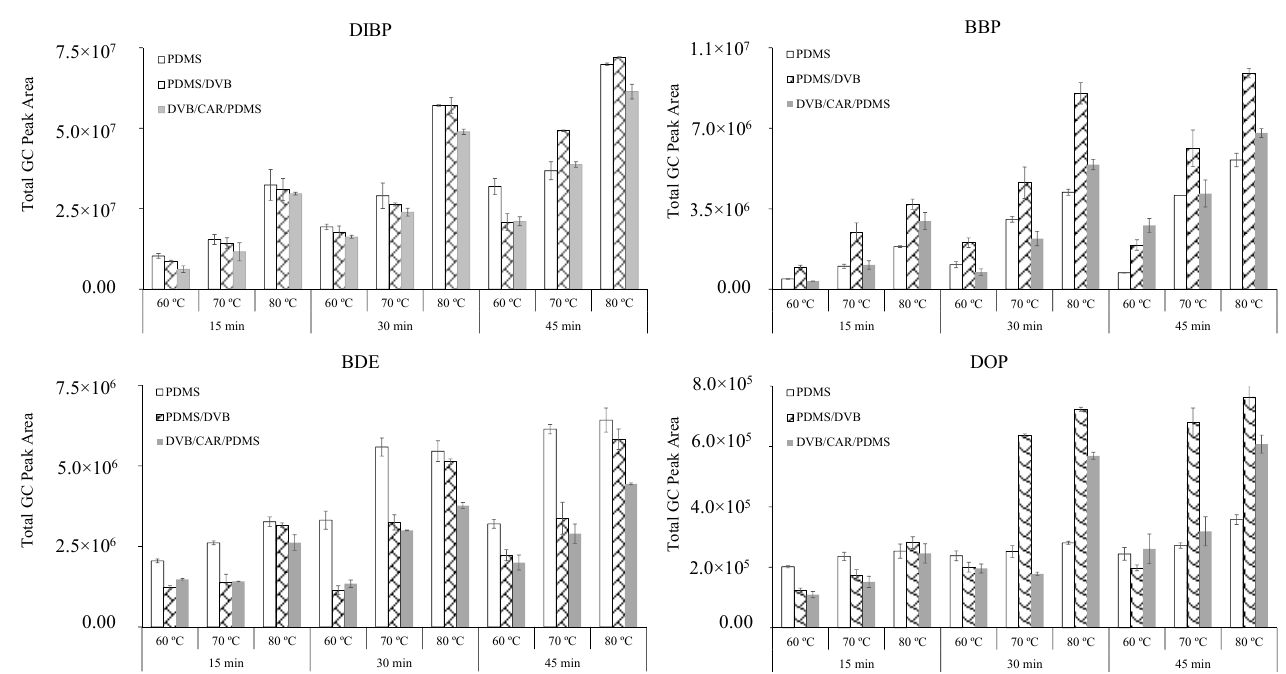
Figure 1. Multivariate analysis for HS-SPME optimization of phthalates target. Conditions: sample volume: 2 mL; concentration of phthalates: 60 µg/L; NaCl amount: 0.2 g; extraction time: 15, 30, and 45 min; extraction temperature: 60, 70, and 80 °C; desorption time and temperature: 6 min and 250 °C.